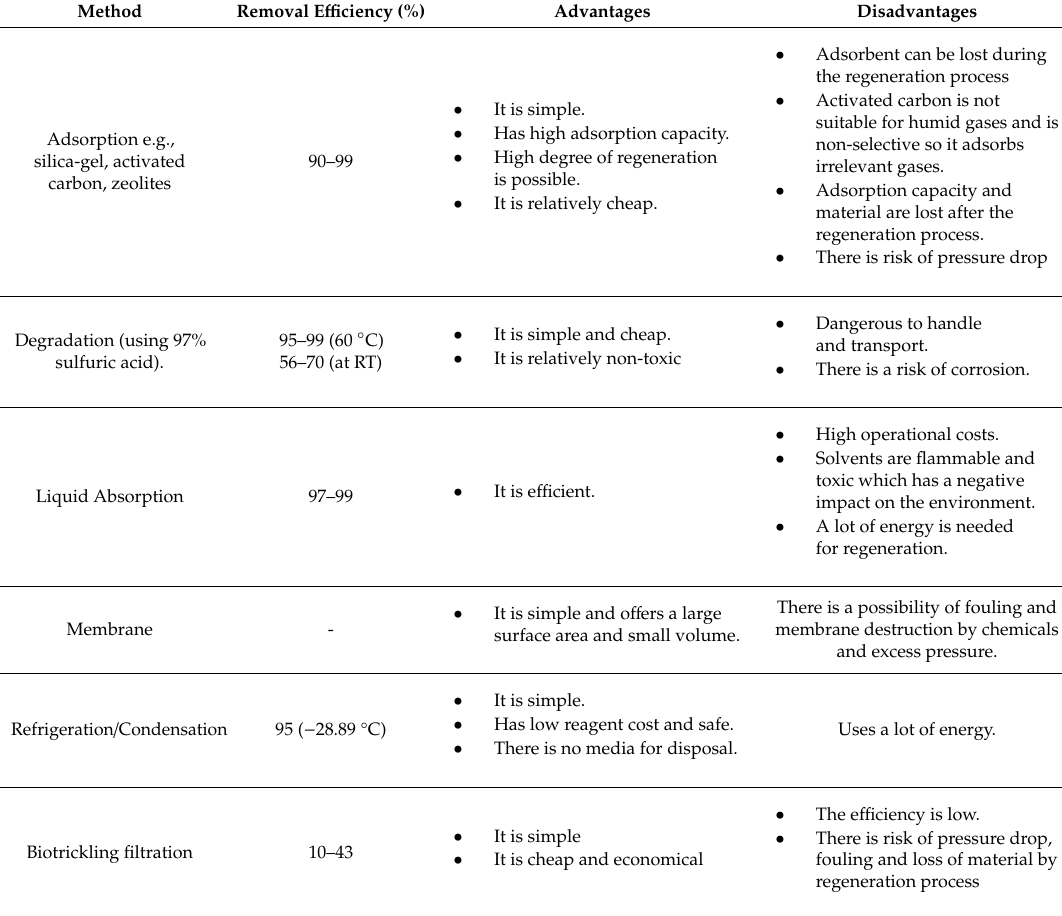
Table 3. Methods for siloxane removal from biogas [5,26,29,30]. Adapted from [26], Canadian Biosystem Engineering: